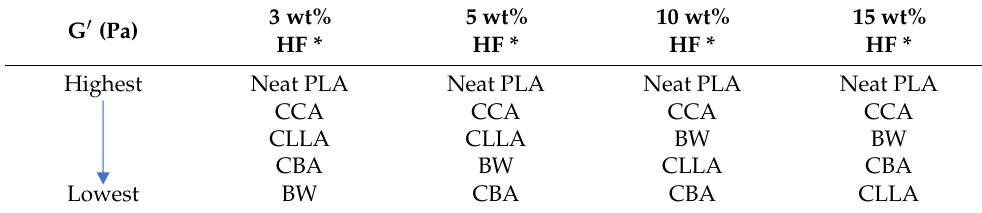
Table 6. Elastic modulus (G (cid:48) ) of PLA–wax blends in the high-frequency range. 3 G (cid:48) (Pa)